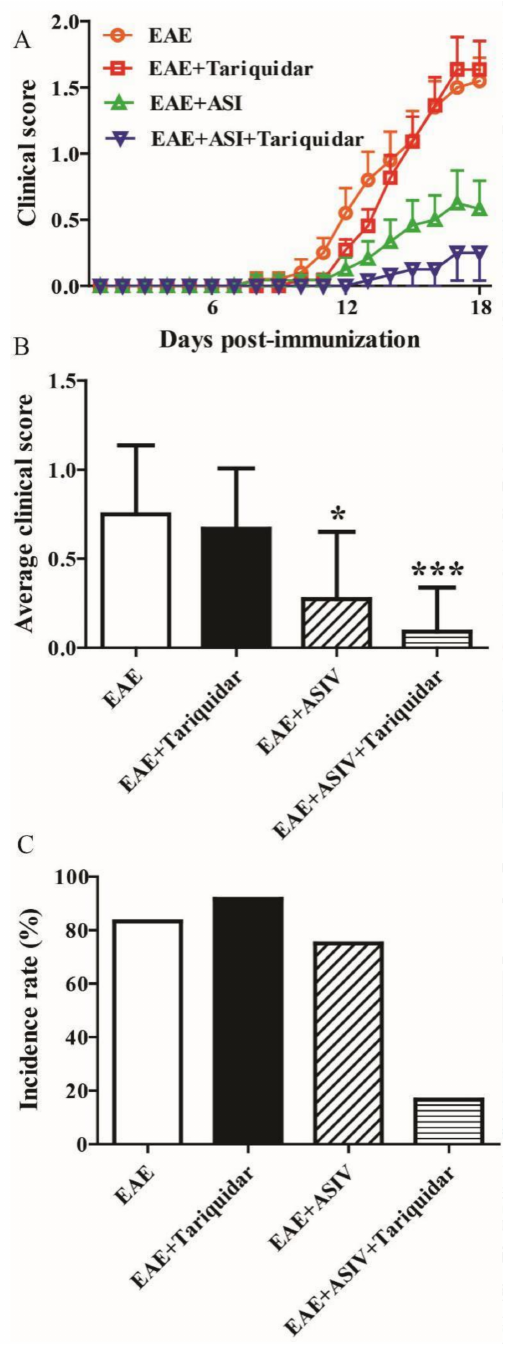
Figure 5. P-gp inhibitor enhances the alleviative effect of ASIV on EAE mice. ( A ) Effects of ASIV combined with tariquiar on the neurobehavior of EAE mice ( n = 12); ( B ) effect of ASIV combined with tariquiar on the average clinical score of EAE mice ( n = 12); ( C ) effect of ASIV combined with tariquiar on the EAE incidence rate ( n = 12). Values are expressed as mean ± SD. Data were analyzed by one-way analysis of variance with Dunnett’s multiple comparison test. * p < 0.05, *** p < 0.001 vs. EAE